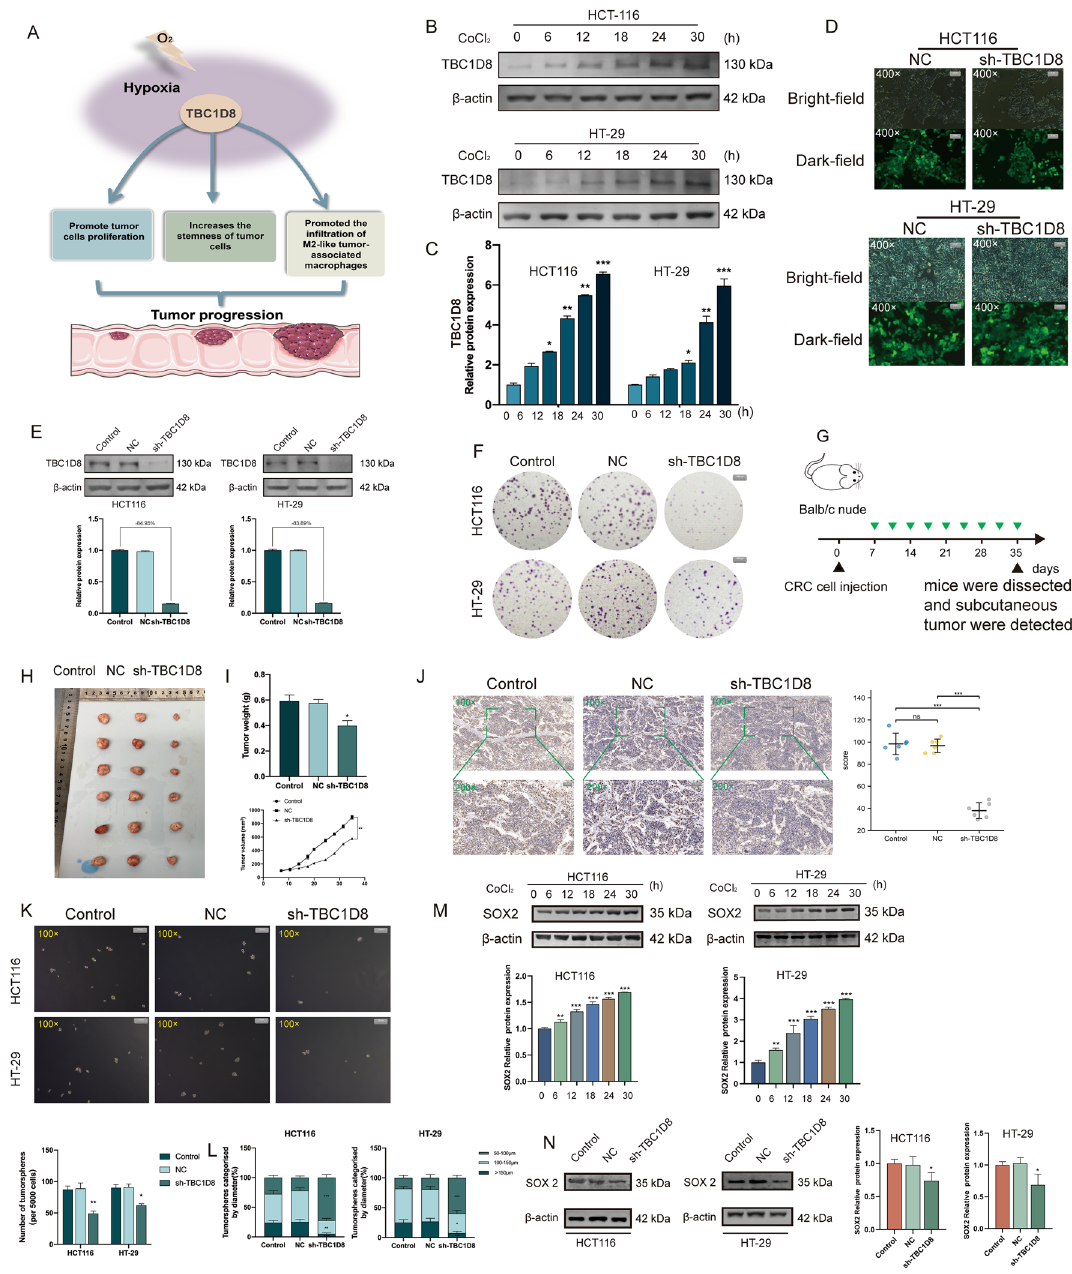
Figure 6. TBC1D8 can be induced by hypoxia conditions, thereby contributing to tumor proliferation and tumor stemness. ( A ) Schematic model of the possible role of TBC1D8 in CRC. ( B , C ) Effects of CoCl2-induced hypoxia on TBCD18 expression. ( D , E ) Transfection efficiencies (%) shown by Green fluorescent protein (GFP) expression and western blotting (Magnification, × 400, scale bars = 20 μm). ( F ) Clone formation capability of CRC cells transfected with NC and sh- TBC1D8 constructs, shown by colony formation determination (Magnification, × 1, scale bars = 1000 μm). (G) Schematic diagram of subcutaneous tumor models. ( H ) Xenograft mouse tumors (n = 6 mice per group). ( I ) Volumes of xenograft tumors measured twice a week and weights of xenograft tumors at completion of the study. ( J ) IHC staining of Ki-67 proteins in mouse xenograft tumor tissues (Magnification, × 100, scale bars = 100 μm; Magnification × 200, scale bars = 20 μm). All the IHC scores were repeated three times using a double-blind method.Statistical analysis All experiments were repeated at least three times, independently. ( K ) Sphere-forming assay of cells (magnification, × 100, scale bars = 100 μm). ( L ) The number of cell spheres and the sphere size were measured. All experiments were repeated at least three times, independently. ( M ) The relative expression level of SOX2 under hypoxic condition was detected using Western blot analysis (n = 3 replicates). ( N ) The relative expression level of SOX2 levels in CRC cells transfected with NC and sh- TBCID8 , were examined using western blot analysis (n = 3 replicates). Data are means ± SEM *p < 0.05; **p < 0.01; ***p < 0.001. One-way ANOVA was conducted. All experiments were repeated at least three times,